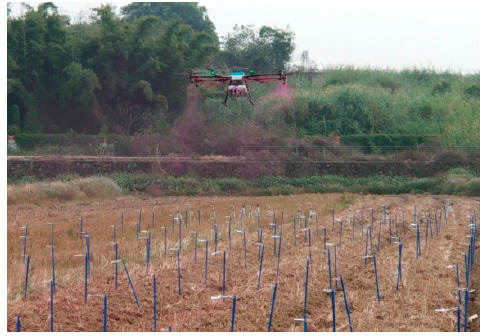
Figure 15. The spray test site.